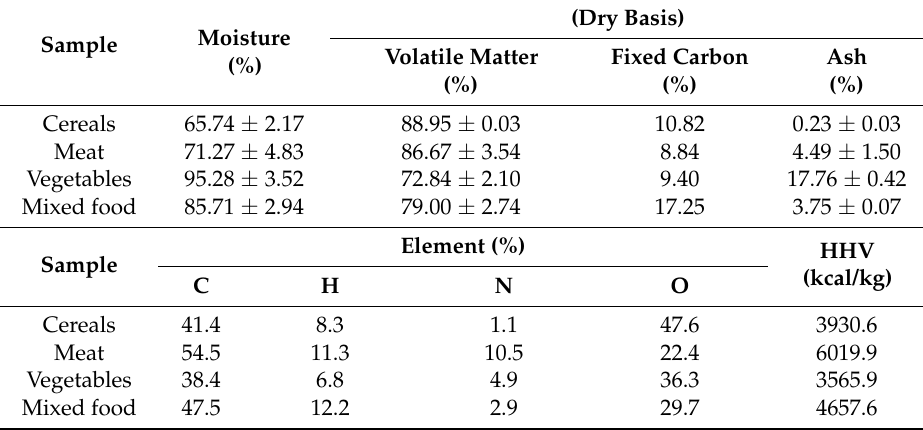
Table 2. Chemical characteristics of the food